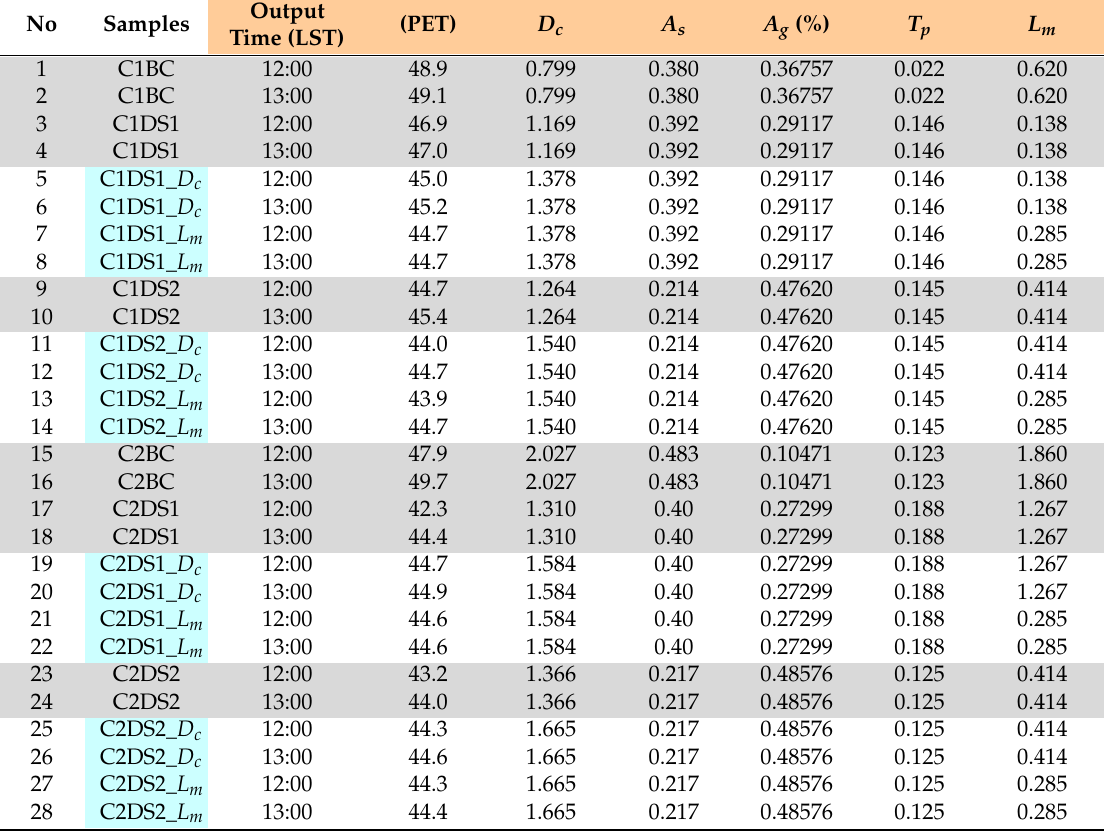
Table 3. Samples of Urban Design Comfort Model (UDCM) regression